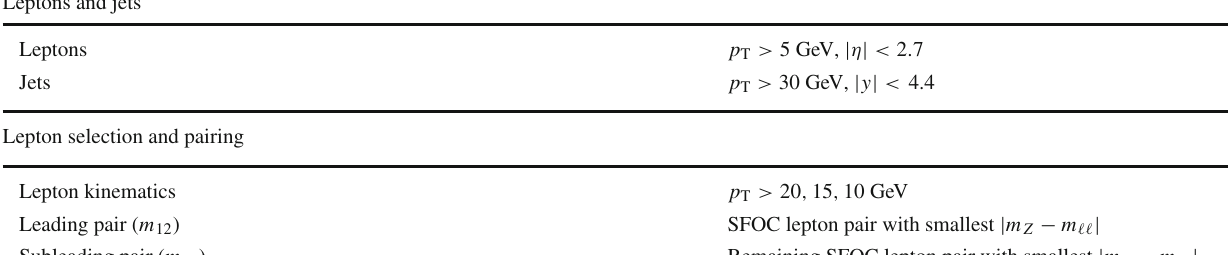
Table 3 List of event selection requirements which define the fiducial phase space for the cross-section measurement. SFOC lepton pairs are same-flavour opposite-charge lepton pairs Leptons and jets